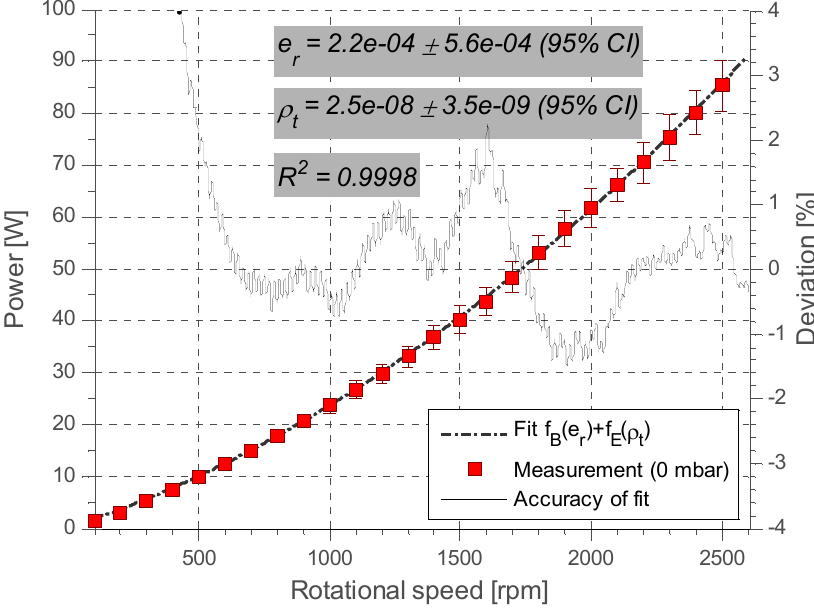
Figure 10. Fit of calculated to measured total power loss using the least squares method, by varying two parameters( e and ρ ) corresponding to mechanical imbalance and r t perpendicular resistivity of the conductors.